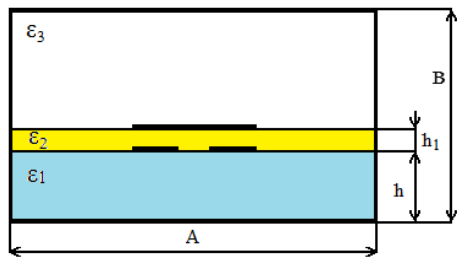
Fig. 9. The cross section of SSL with additional